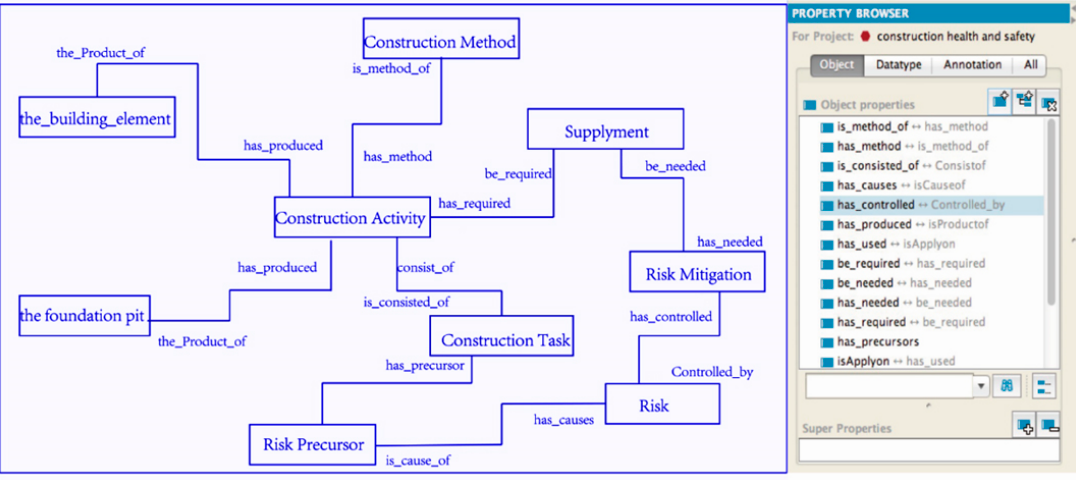
Figure 5. The conversion from UML associations to object properties in HSM-Onto.